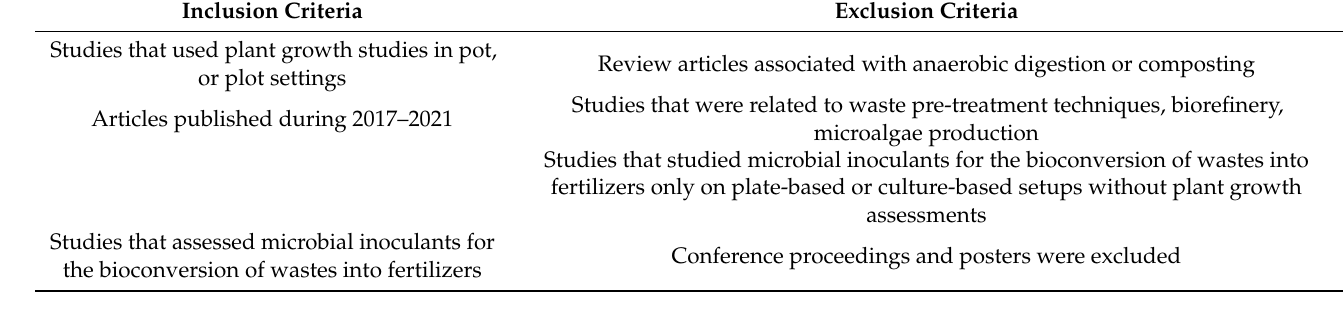
Table 3. Inclusion and exclusion criteria used in this study.